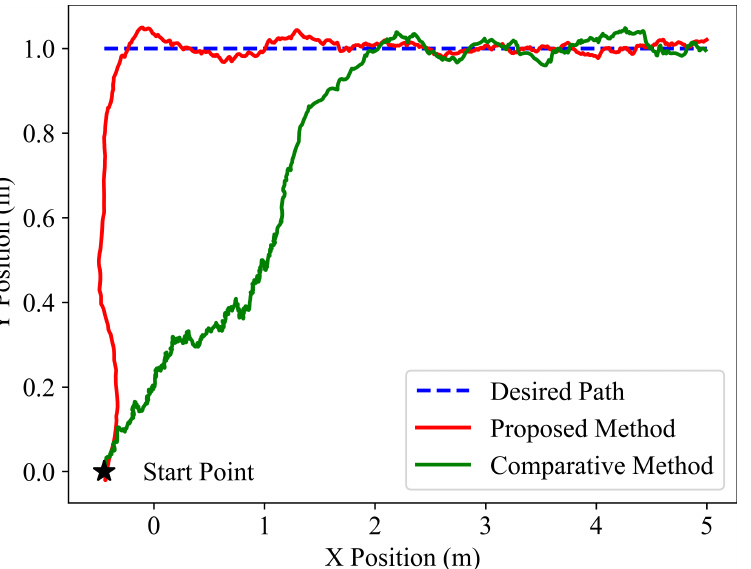
Figure 3. Simulation path following results of the desired line for the proposed hierarchical method and the end-to-end comparative